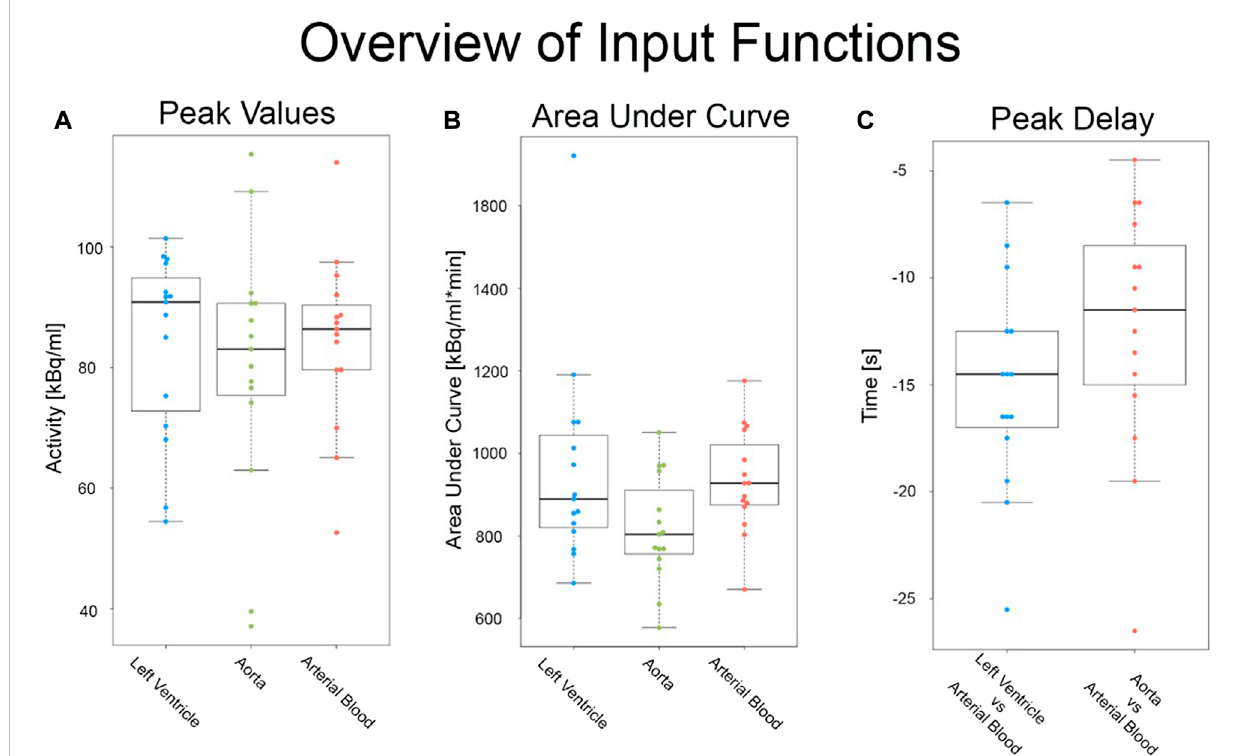
FIGURE 2 Overview of all input functions before motion correction: Comparison of raw (A) peak values, (B) area under the curve and (C) peak delay metrics in both the arterial and image derived input functions from the automatic vendor